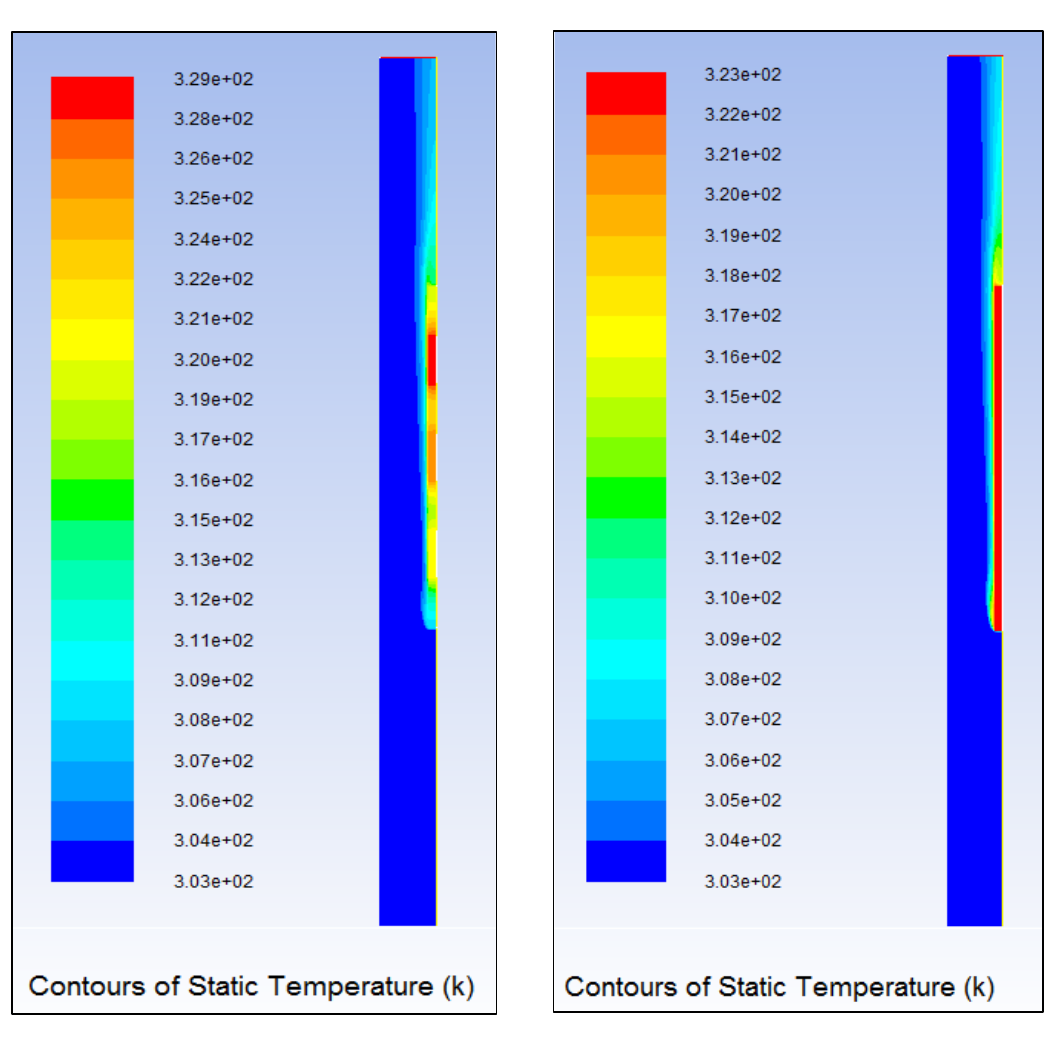
Figure 5. Temperature contours for simpler thermal